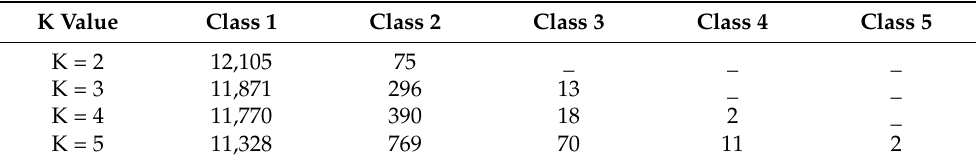
Table 1. Clustering technique results.